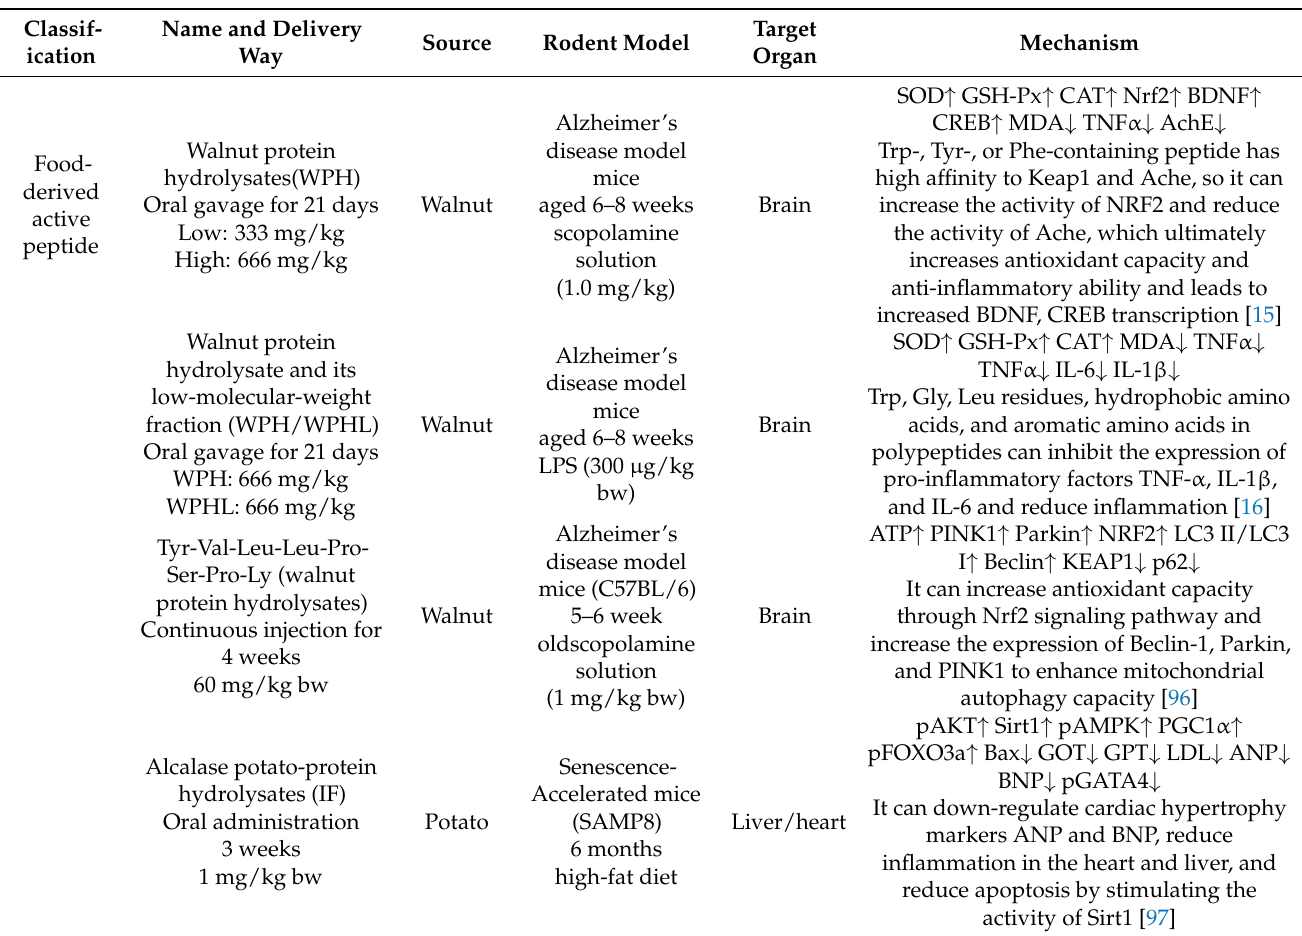
Table 1. Bioactive peptides with anti-aging